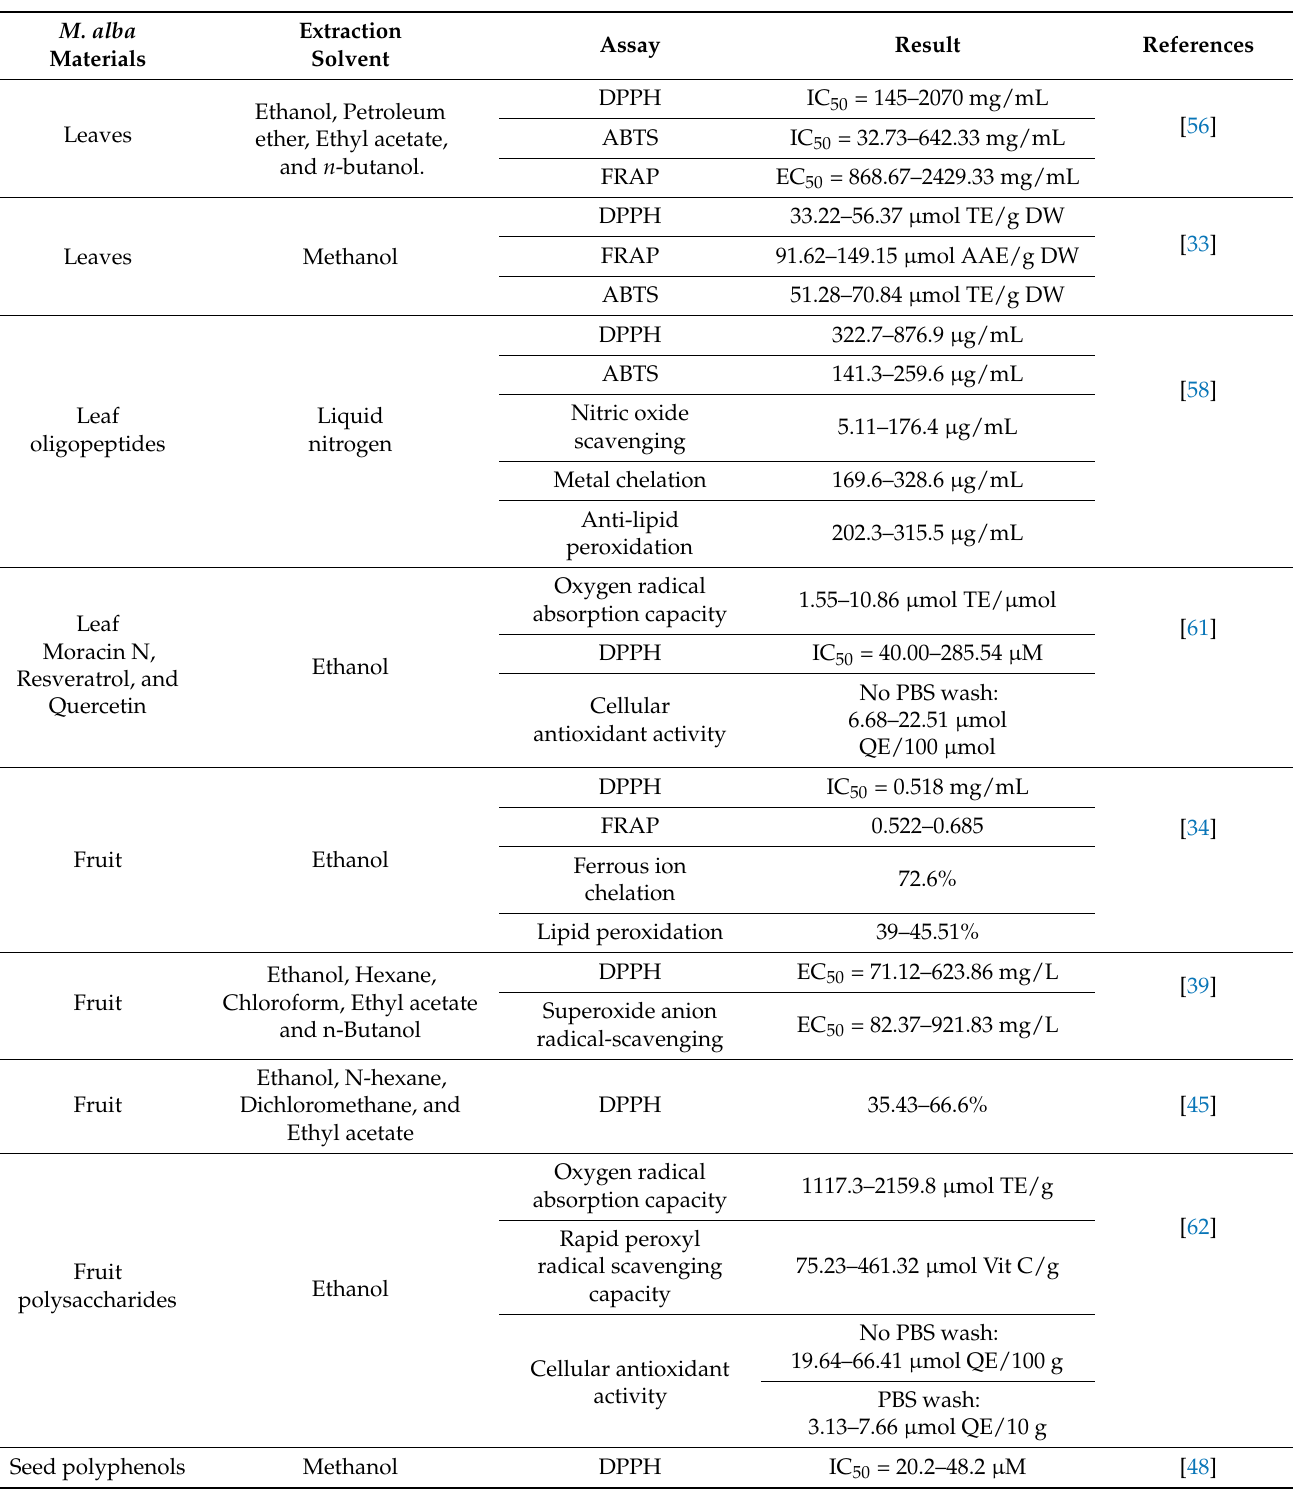
Table 5. Antioxidative properties of M. alba from various